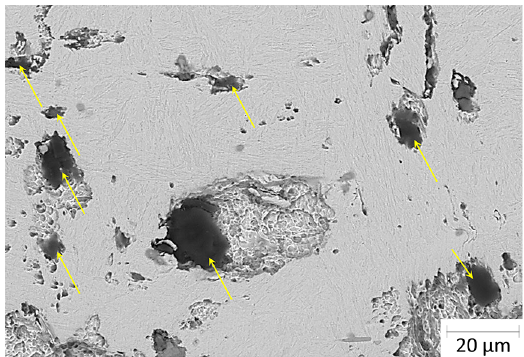
Figure 7. SEM/BSE micrograph indicating large borocarbides precipitates in as-rolled sample.